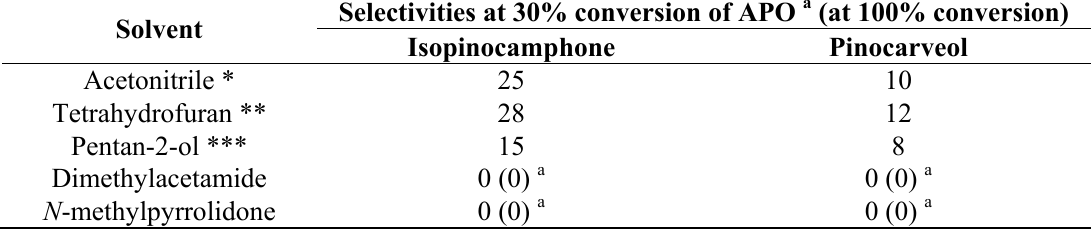
Table 6. The selectivities to undesired by-products isopinocamphone and pinocarveol at